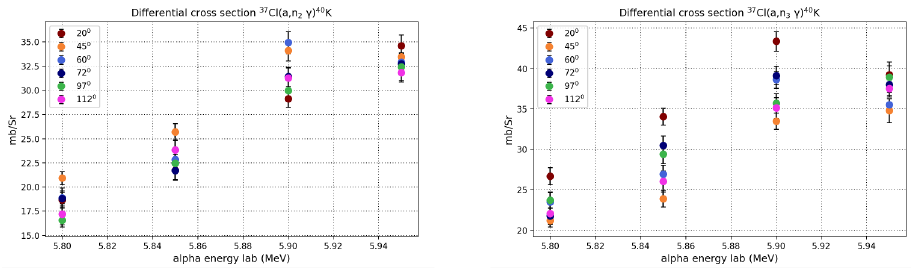
Figure 3. Di ff erential cross sections for 37 Cl( α ,n 2 γ ) 40 K (left) and 37 Cl( α ,n 3 γ ) 40 K (right) reaction chan-